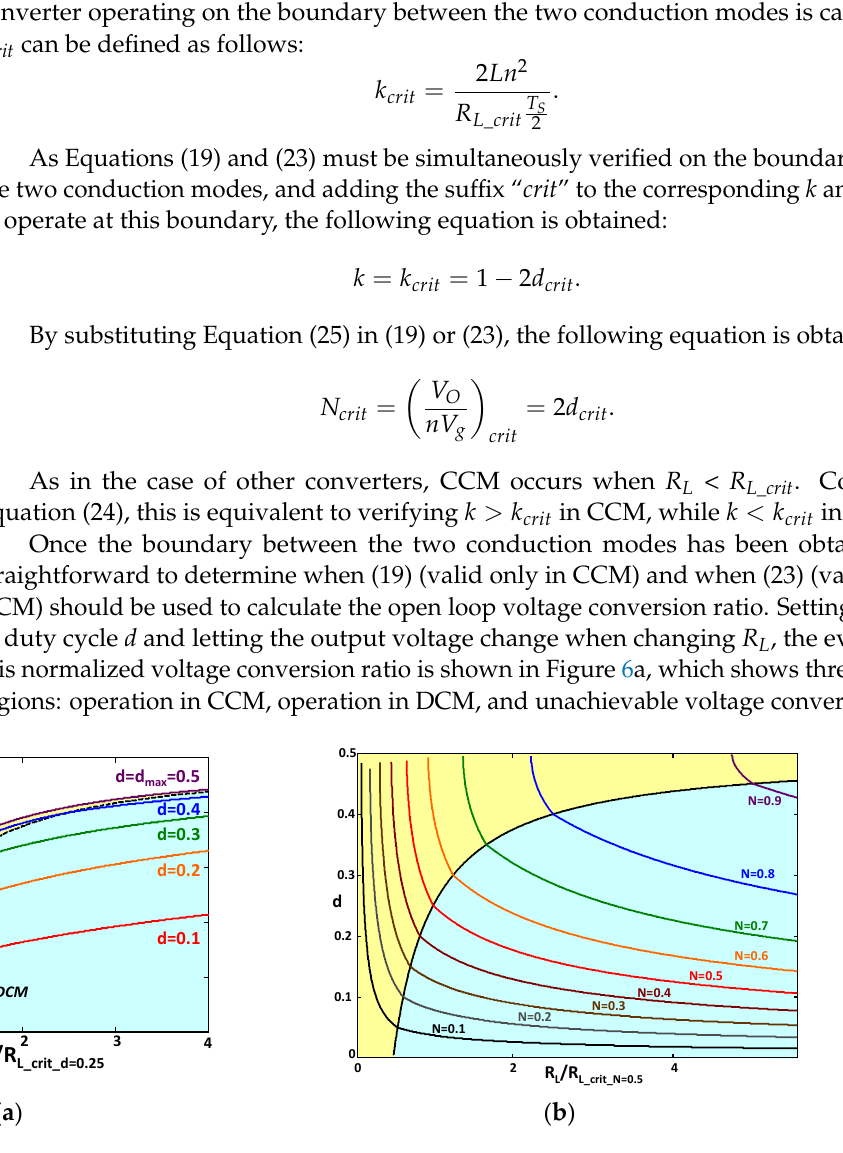
Figure 6. ( a ) Variation of the normalized voltage conversion ratio in open loop based on the normal- ized load resistance. In this normalization, the critical value of R L when d is 0.25 (half of d max ) is used as the base value. ( b ) Variation of the duty cycle of the converter in closed loop, based on the nor- malized load resistance. In this normalization, the critical value of R L when N is 0.5 (half of N max ) is used as the base value.